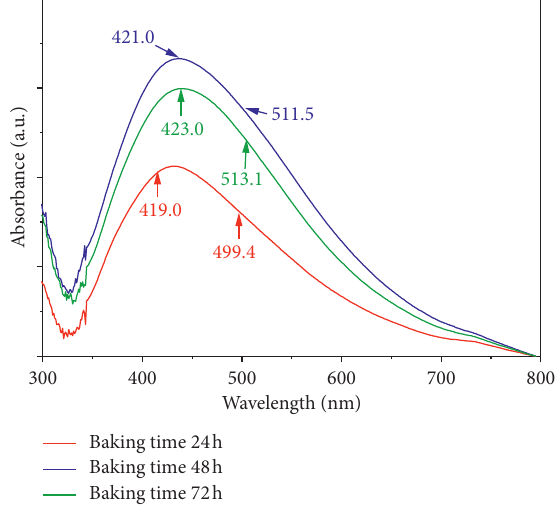
Figure 4: The UV-Vis spectra of samples after different baking times.